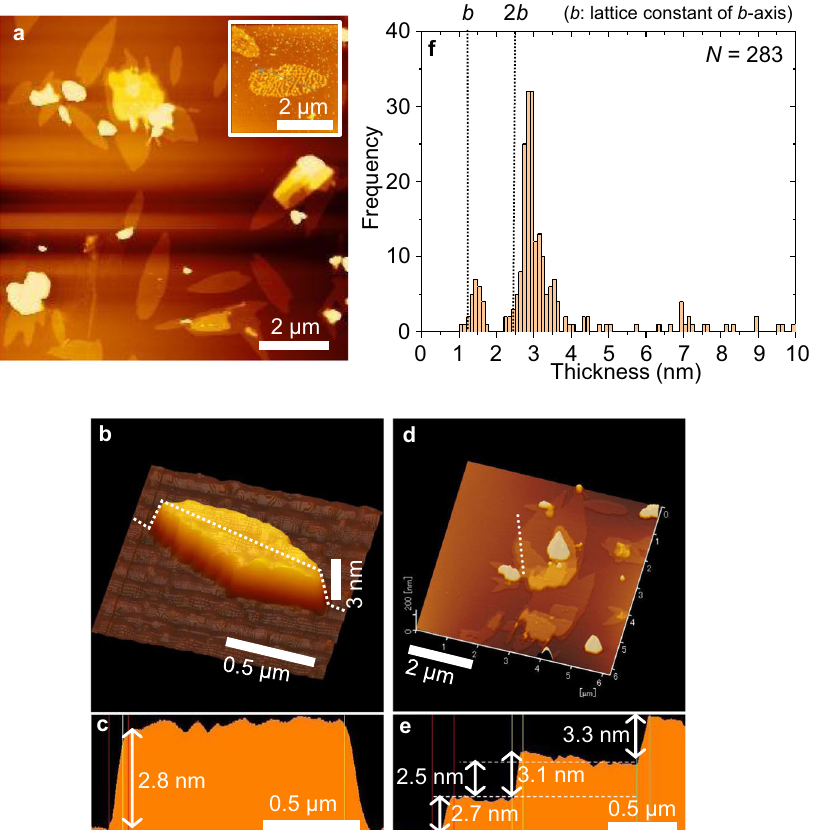
Fig. 3 Topography and surface morphology obtained from AFM. The sample was the fi lter residues of LCCO polycrystals subjected to immersion to NaOH aqueous solution with 5 mol/L concentration and stirring for 6 h. a Low-magni fi cation image. The inset is the image of the collapsed nanosheet. High-magni fi cation images for ( b , c ) the nanosheet and d , e the large plate with steps and terraces. c , e Shows the heights along the white dot lines in ( b ) and ( d ), respectively. f Thickness distribution of the nanosheets.